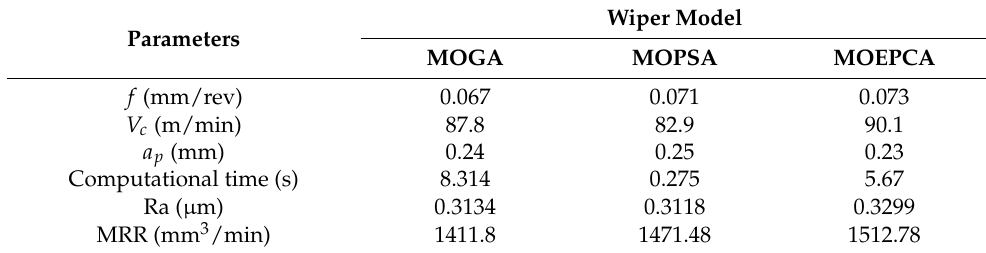
Table 6. The optimal solution results for the wiper model.